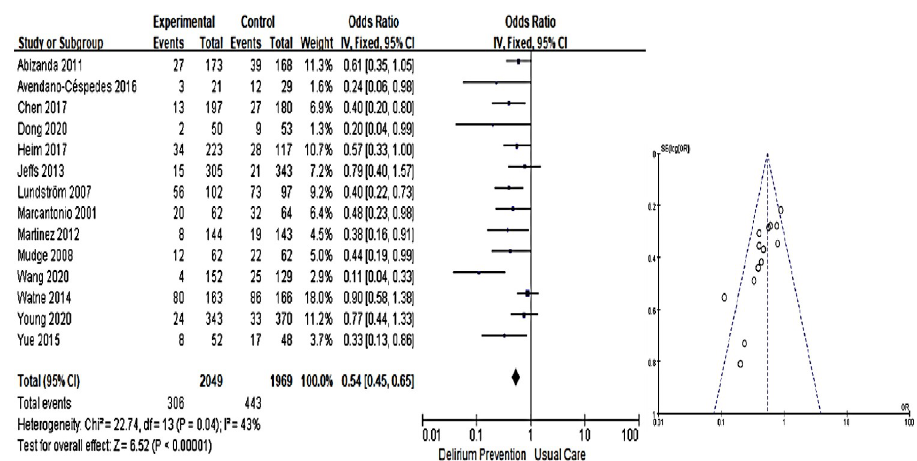
Fig 3. Forest plot of total effect of on the incidence of delirium and funnel